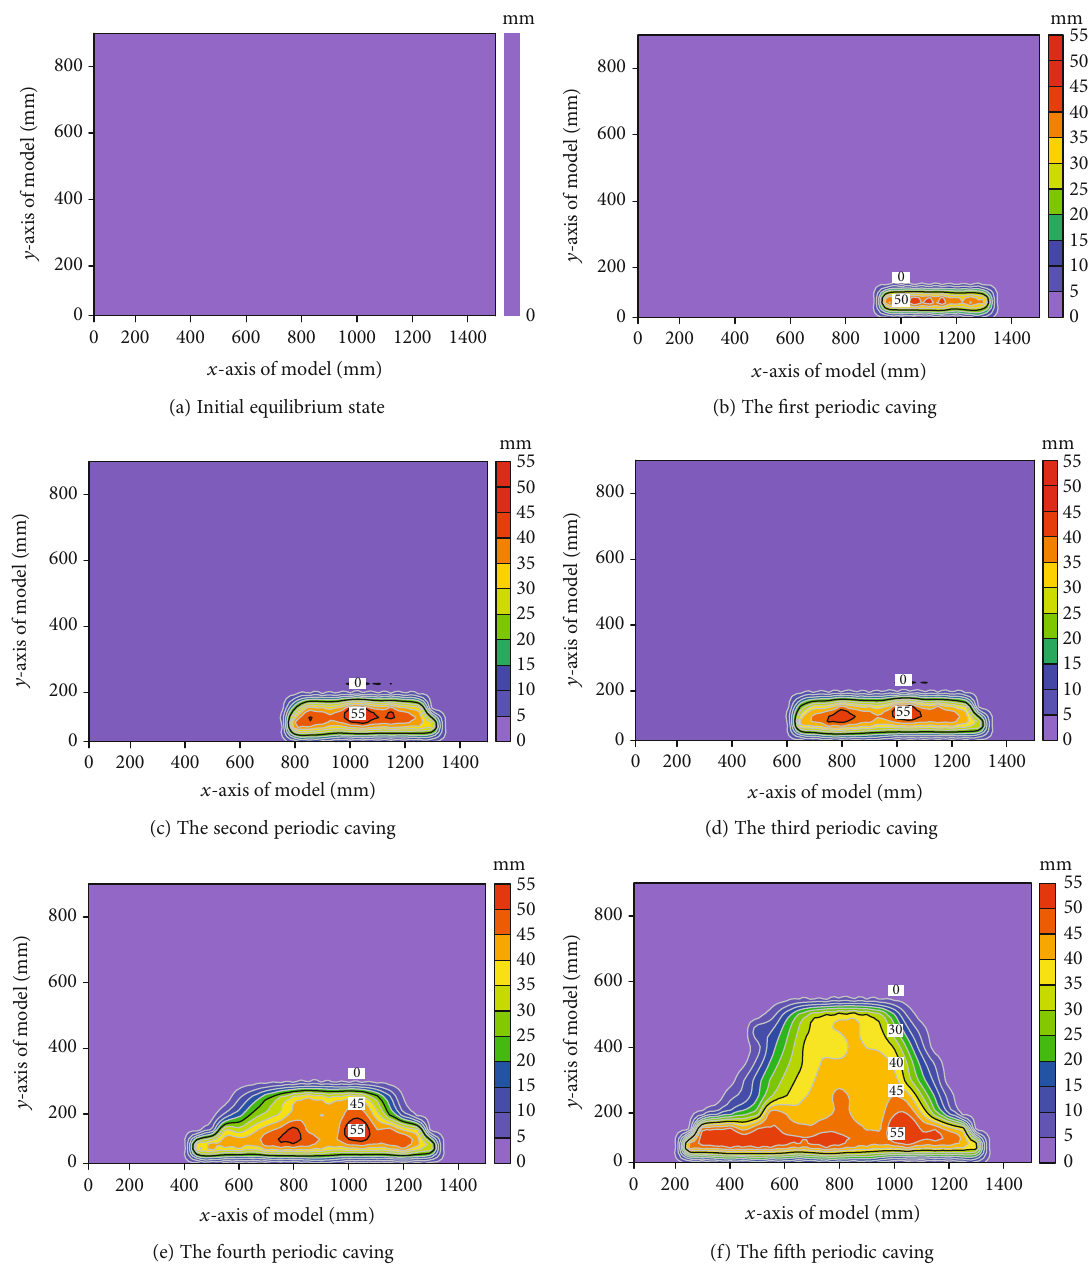
Figure 6: Vertical displacement variation of fi ve periodic caving of extra-thick